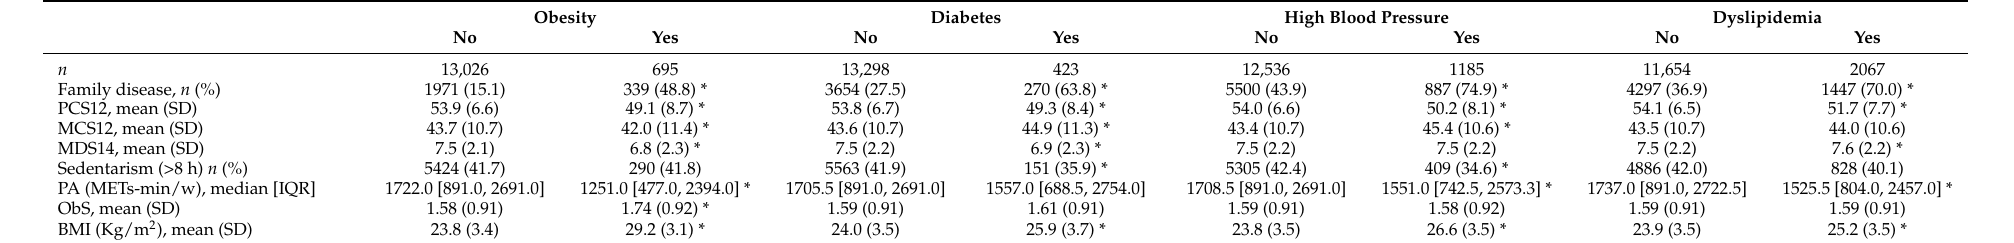
Table 4. The phenotypic characteristics, HRQoL and lifestyle of participants in the NUTRiMDEA study stratified by metabolic diseases.